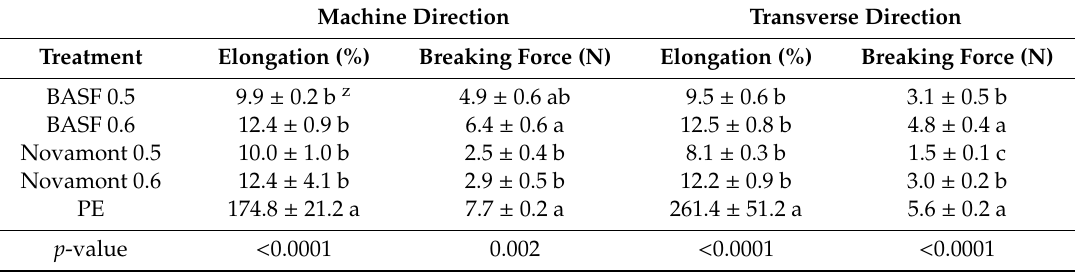
Figure 3. Appearance of polyethylene (PE) and biodegradable plastic (BASF and Novamont, where 0.5 and 0.6 indicate the film thicknesses: 0.5 mil = 12.7 µ m and 0.6 mil = 15.2 µ m) treatments applied to raised beds in a raspberry field in May 2017 and photographed 58 days after transplanting (DAT) (14 July 2017), 136 DAT (30 Sept. 2017), 197 DAT (30 November 2017), and 306 DAT (19 March 2018). Table 3. Elongation (%) and breaking force (N) in the machine and transverse directions for polyethylene (PE) and biodegradable plastic mulch (BASF and Novamont, where 0.5 and 0.6 indicate the film thicknesses: 0.5 mil = 12.7 µ m and 0.6 mil = 15.2 µ m) treatments collected from the soil surface on 20 January 2018 (8 months of field exposure); all mulches were applied on raised beds in a raspberry field in May 2017.